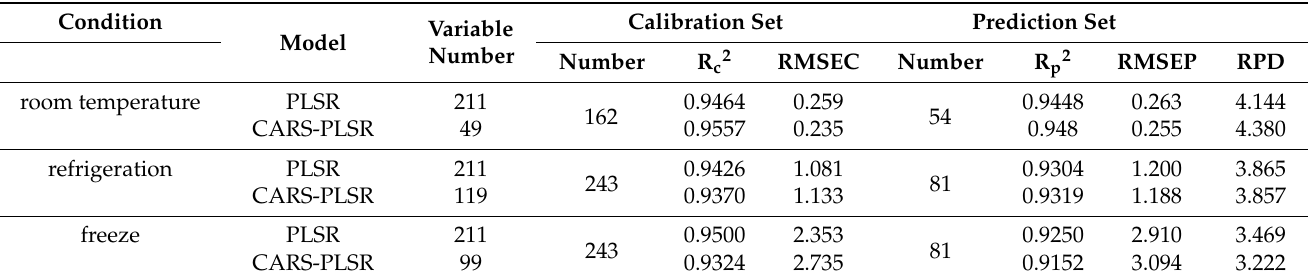
Table 2. Prediction results based on PLS regression (PLSR) and competitive adaptive reweighted sampling-PLSR (CARS- PLSR)